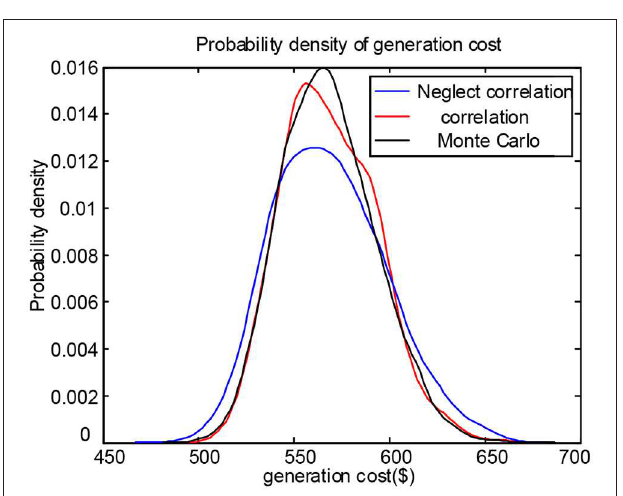
FIGURE 11 | The mean of bus